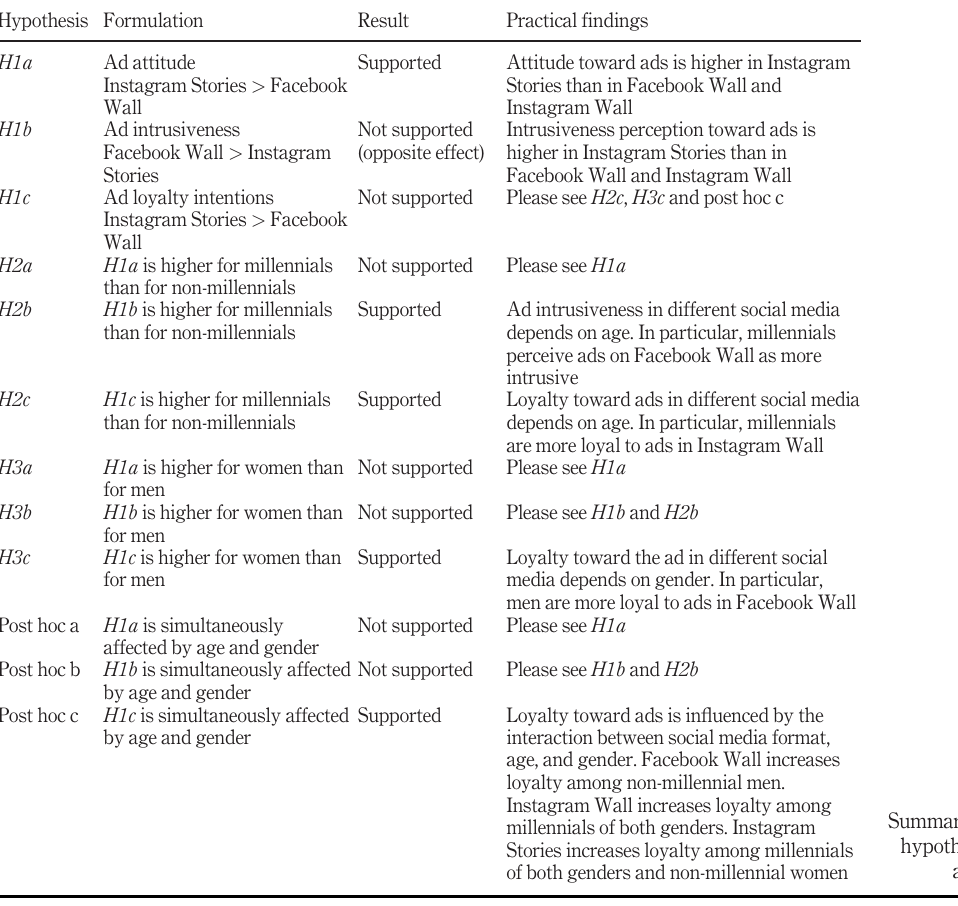
Table VII. Summary of